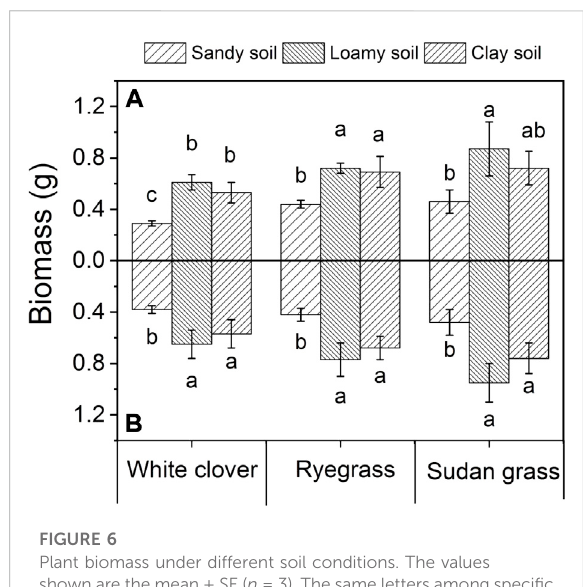
FIGURE 5 Plant height of plants under different soil conditions. The values shown are the mean ± SE ( n = 3). The same letters among speci fi c treatments are not signi fi cantly different according to Duncan ’ s (0.05). (A) : treatment without glycine; (B) : treatment with glycine.